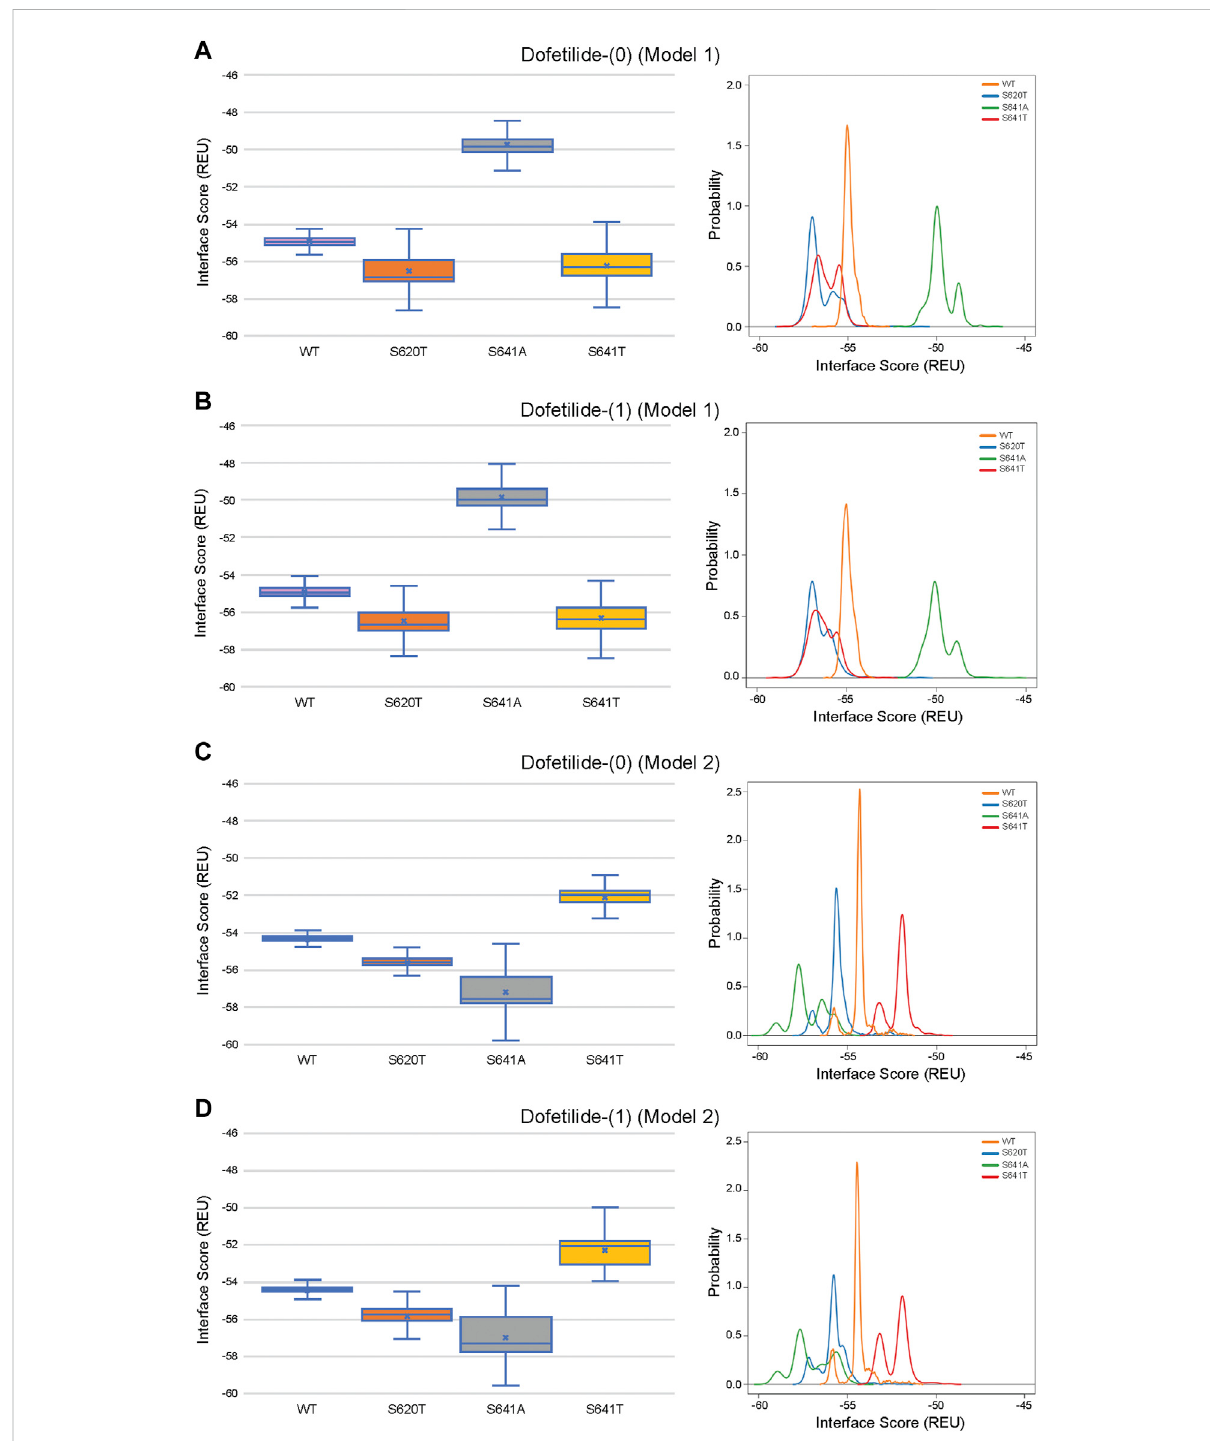
FIGURE 10 Interface score distributions for hERG channel interactions with dofetilide. Left Panels: Box-and-whisker plots of interface scores in REU. Right Panels: Probability density charts plotting probability density against interface scores (REU) All plots utilize 2,000 generated structures. Plots are de fi nedfor (A) neutral(0)model1, (B) charged(1)model1, (C) neutral(0)model2and (D) charged(1)model2structures.ErrorbarsrepresentMaxand Min values; Mean (x); Median (horizontal